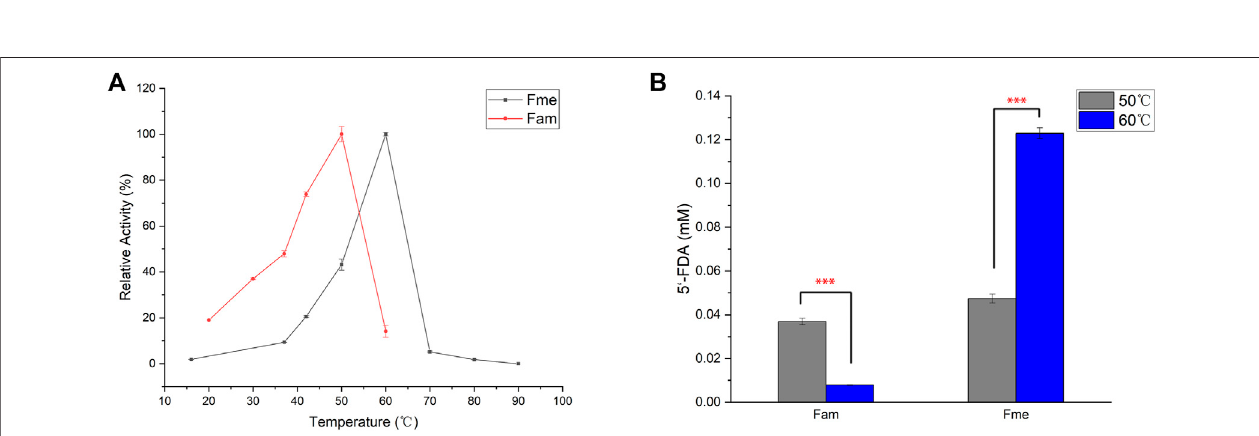
FIGURE 2 | HPLC analysis of the products in different samples. The assays were carried out with Tris-HCl (50 mM, pH 7.8) containing 200 mM KF, 1 mM SAM, and 500 μ g/ml crude enzyme at 50 ° C for 2 h.